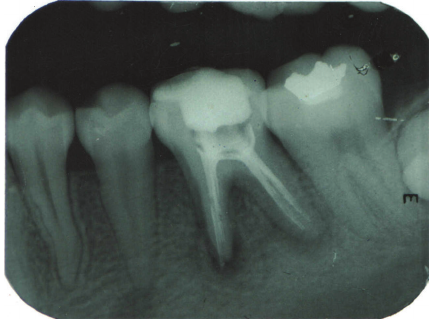
Figure 7: Metapex placed (46).